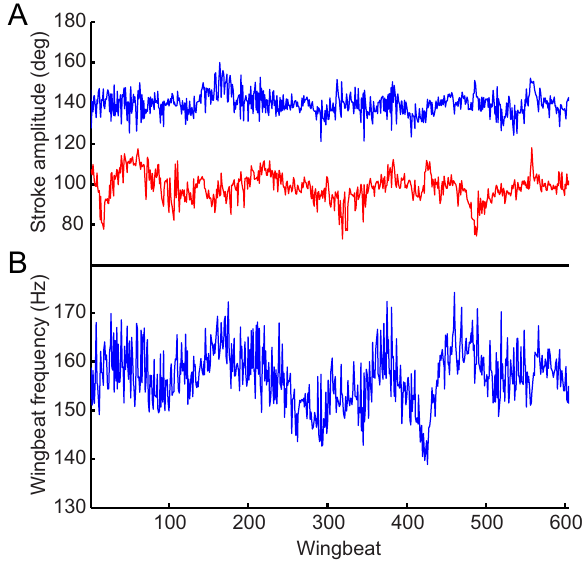
Figure 3. Wing kinematic parameters for one fly over entire recording period. (A) Stroke amplitude for the left (blue) and right (red) wings. (B) Wingbeat frequency, calculated as the mean of both